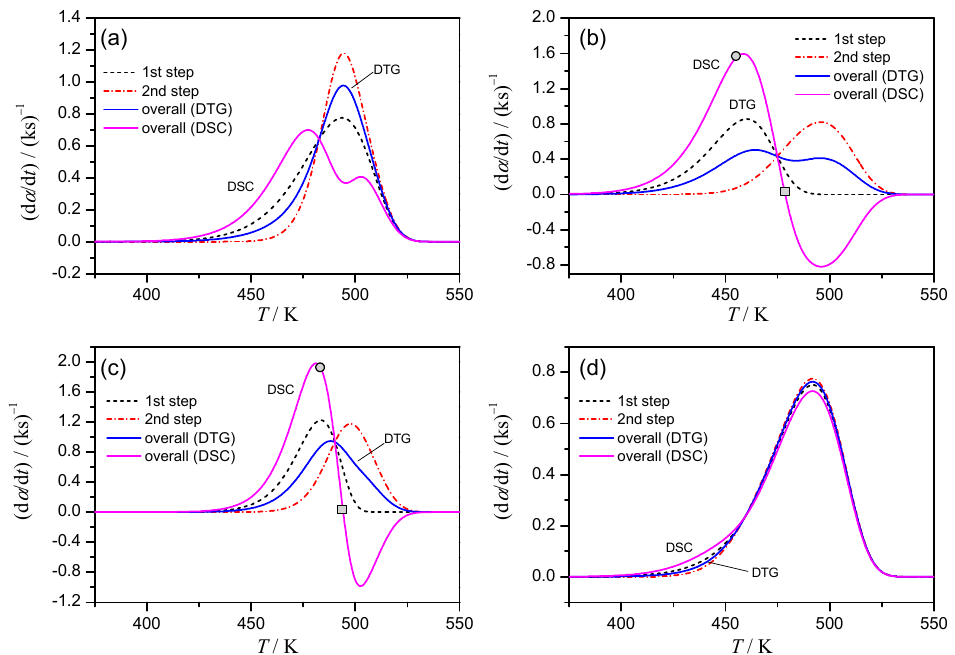
Figure 1. Comparison of the simulated kinetic curves at β = 2 K min − 1 for each component reaction step calculated according to Equation (2), overall kinetic curve calculated according to Equation (3) (from DTG), and overall kinetic curve calculated according to Equation (4) (from DSC): ( a ) Case 1, ( b ) Case 2, ( c ) Case 3, and ( d ) Case 4.